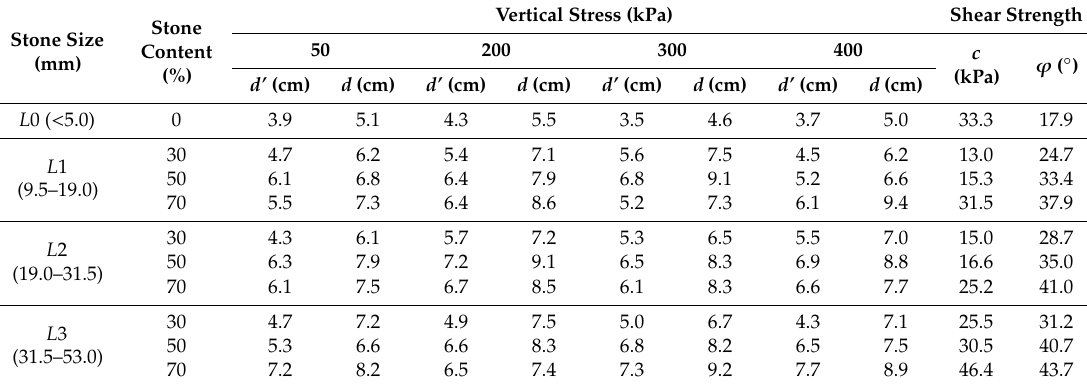
Figure 7. Deformation characteristics and parameters of the shear zone. Table 2. Thickness of the key shear zone ( d’ ) and shear zone ( d